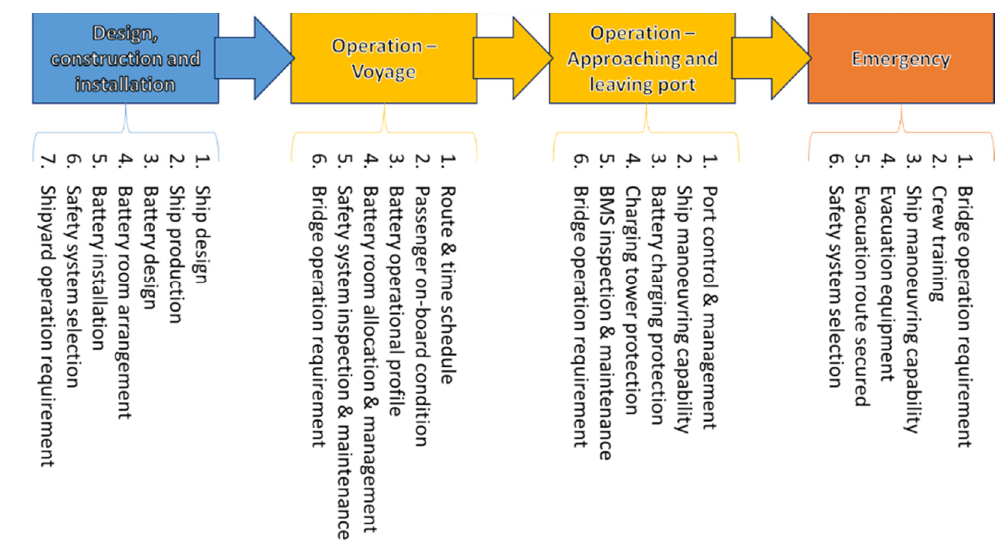
Figure 6. Scope of risk assessment study.